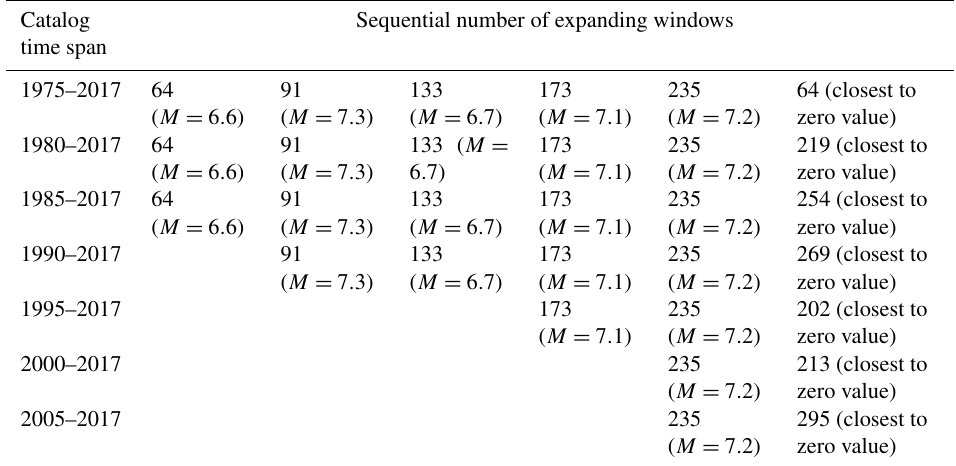
Table 2. Comparison between expanding by 10 data windows with the strongest earthquakes occurrences and windows with IDT values closest to zero. Representative threshold M = 3 . 6.